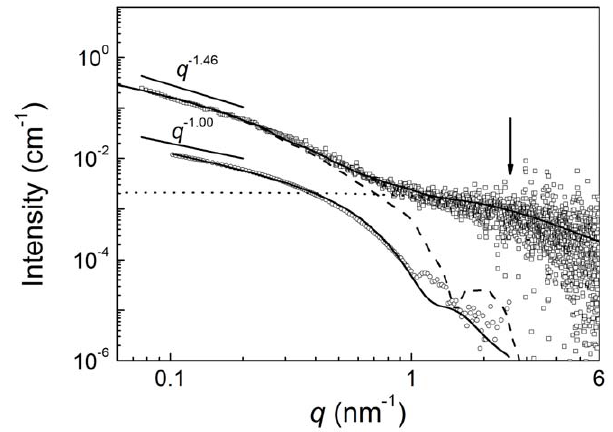
Figure 6. SAXS data of polymerized ActM and rabbit actin. Data of rabbit F-actin (circles) are from [29]. Best fit curves (solid lines) are from a cylinder function for rabbit actin with a radius of R =3.0 nm and a parallelepiped for ActM (squares) with c =4.2 nm and b =15 nm. Length of cylinder and parallelepiped where held constant for fitting at 500 nm. The power-law scalings at low q are indicated as straight lines. The arrow points at the q -region where the scattering of short random-coil structures is visible. Contributions of the parallelepiped and the random coil structure are displayed (dashed and dotted line,